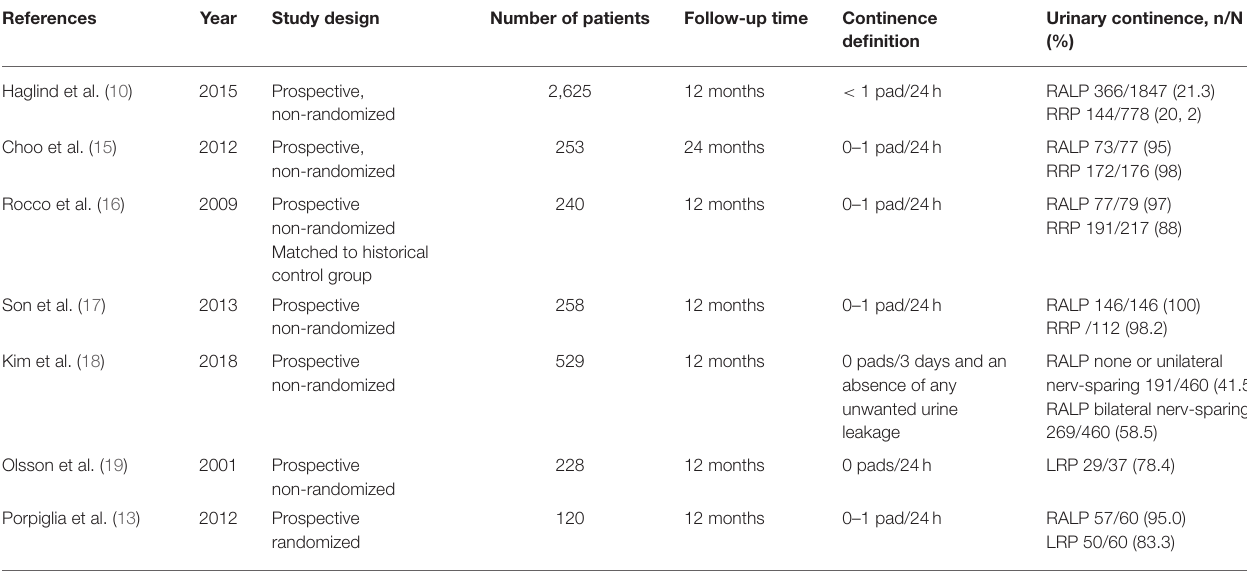
TABLE 1 | Continence rates after radical prostatectomy of selected clinical